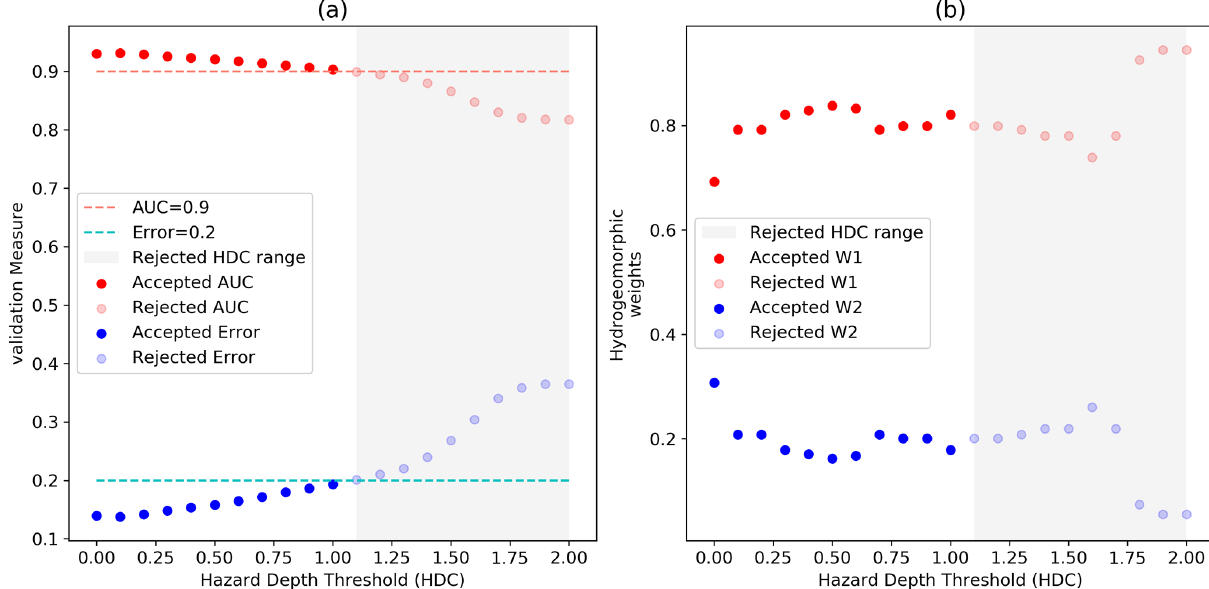
Figure 6. Calibration of the I HD index for Hurricane Matthew. (a) The variation in performance measures AUC (red) and error (blue) for different hazard depth cutoff (HDC) values and (b) the optimum weights of the I HD index for different HDC values. The dashed lines show the maximum error (0.2) and minimum AUC (0.9) that are acceptable for flood hazard mapping. Using these criteria, the gray regions show that the hydrogeomorphic model cannot provide acceptable results for HDC values higher than 1.1m.